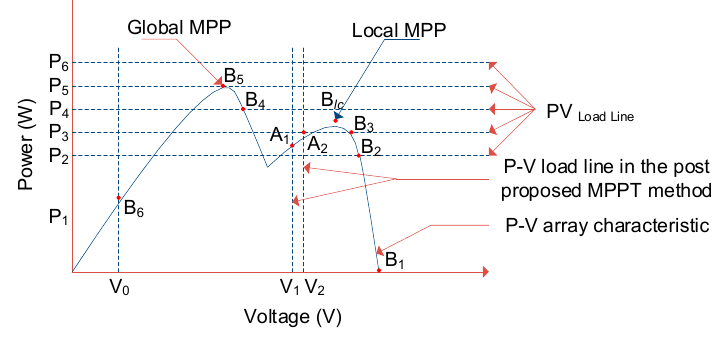
Figure 9. Constant load line operating principles.